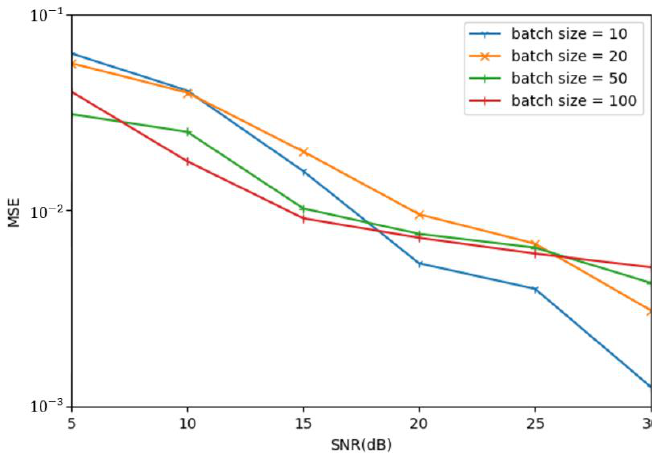
Figure 7. Mean square error (MSE) versus SNR for the proposed scheme with varying batch sizes.